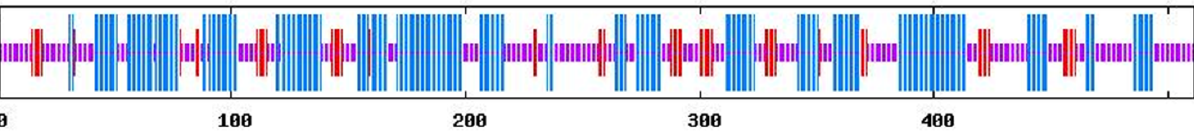
Figure 1. Predicted secondary structure of Tianfu goat PPP3CA amino acid (AA) sequence. The blue line represents α -helix, the red line represents extended strand, and the purple line represents random